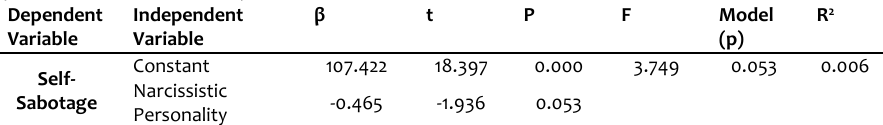
Table 7: The Results of Regression Analysis on Whether the Self-Sabotage Levels of the Students are Affected by Their Narcissistic Personality Levels Dependent